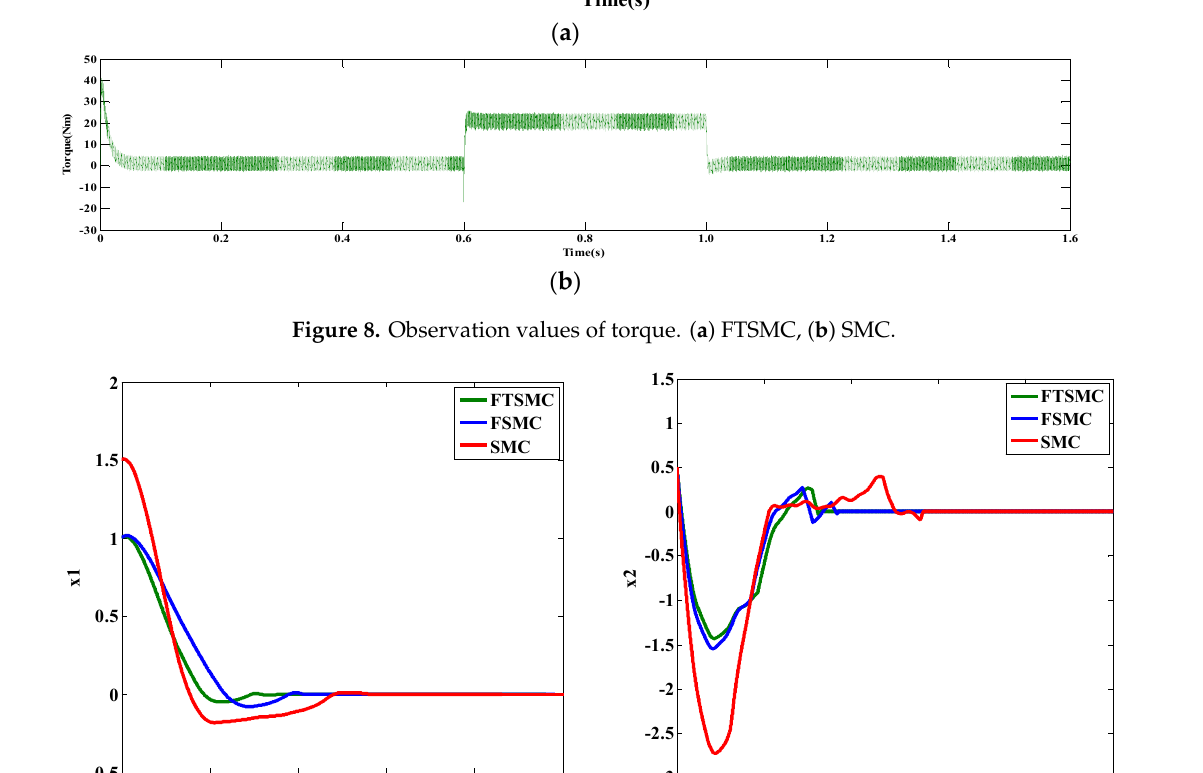
Figure 7. Three-phase current curve of PMIWM. ( a ) FTSMC, ( b ) sliding mode control (SMC).